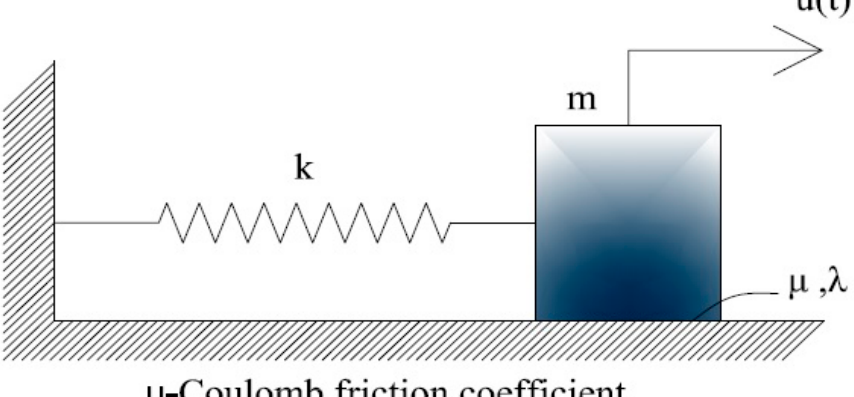
Figure 2. Block diagram of a mass-spring system subjected to friction. Lagrangian of the system is given